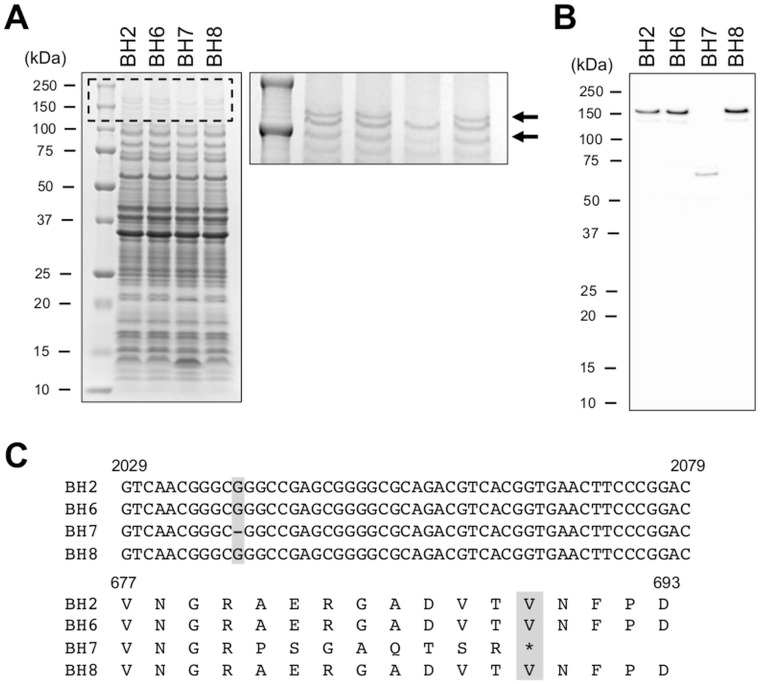
Lack of BipA production in Bordetella holmesii isolate BH7.(A) Comparison of the protein expression profiles of the clinical isolates BH2, BH6, BH7, and BH8. Total protein (20 μg) was subjected to SDS-PAGE followed by CBB staining (left panel). The dashed-boxed area is enlarged (right panel). The arrows indicate the bands that were identified as BipA by nano-LC-MS/MS analysis. (B) Analysis of BipA production in B. holmesii isolates. Total protein (2 μg) was subjected to immunoblot analysis with anti-BipA antisera. (C) Comparison of BipA sequences among the isolates. The bipA gene of BH7 encodes a deletion of a guanine (G) at nucleotide position 2039 (gray box). The deletion mutation generates a premature stop codon at nucleotide position 2066. The translation stop site (amino acid 689) is shown in the deduced amino acid sequence (BH7, gray box).